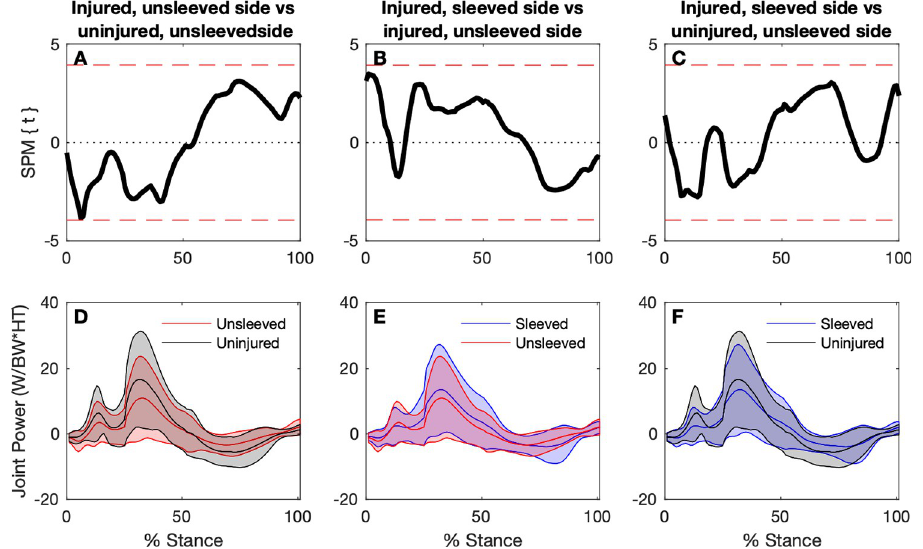
Fig 5. Knee joint power time-continuous comparisons for the uninjured (unsleeved) sides, and ACL injured sides for sleeved and unsleeved conditions. Top panels: SPM paired t-tests for comparisons between injured (sleeved versus unsleeved) and uninjured sides. Joint power curves (mean and ± 1 standard deviation bands) for each respective test are shown in the bottom panels.